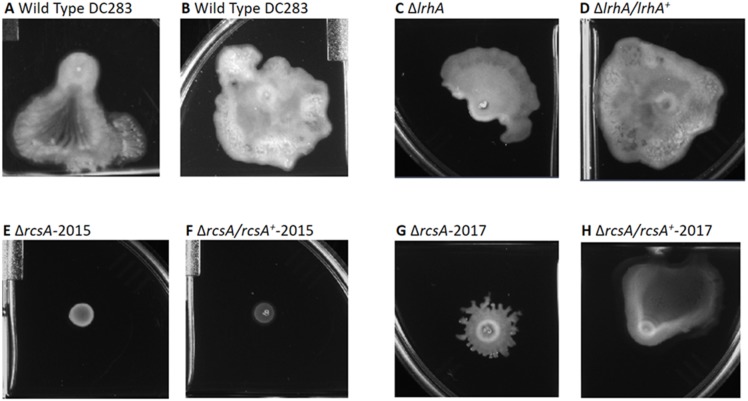
Impact of RcsA and LrhA on surface motility of P. stewartii.The pictures show the analysis of surface motility in P. stewartii DC283 strains. Examples of wild type unidirectional (A) or omnidirectional surface motility (B) are shown as controls. The ΔlrhA/lrhA+ complementation strain (D) is similar to the control in (B), while the ΔlrhA strain has reduced surface motility expanding over a smaller surface area (C), as has been previously observed (Kernell Burke et al., 2015). Both ΔrcsA strains had dramatically reduced surface motility (E and G) as well as the ΔrcsA/rcsA+-2015 strain (F). The ΔrcsA/rcsA+-2017 strain was complemented for the defect in surface motility (H). All pictures were taken at the same magnification after 2 days of incubation at 30 °C in a closed plastic box.